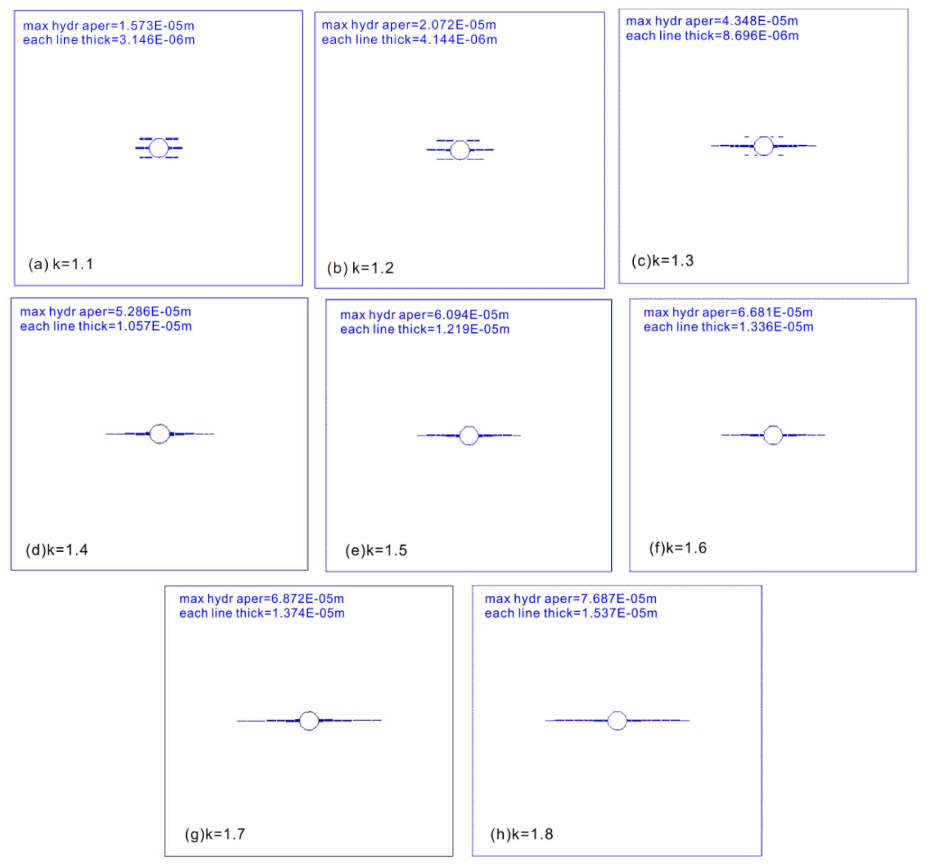
Figure 6. The relationship between hydraulic fracture geometry and stress ratio. ( a ) K = 1.1; ( b ) K = 1.2; ( c ) K = 1.3; ( d ) K = 1.4; ( e ) K = 1.5; ( f ) K = 1.6; ( g ) K = 1.7; ( h ) K =